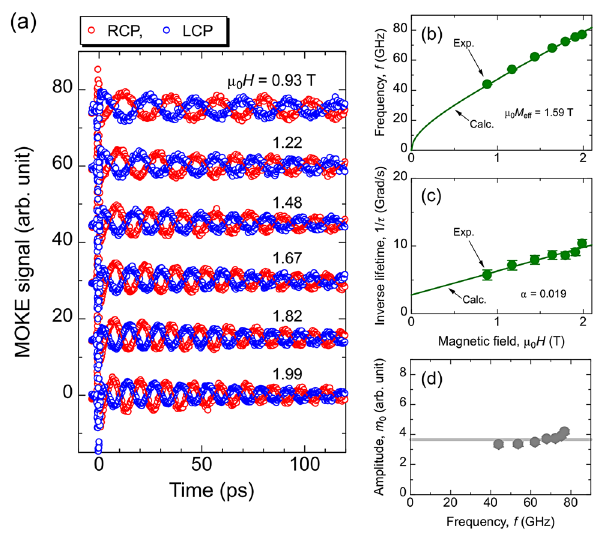
Figure 2: (a) Circularly polarized laser pulse induced magnetization precession in 2-nm-thick FeCo/3-nm-thick Pt bilayer with different magnetic fields μ 0 H . (b) Precession frequency and (c) inverse lifetime obtained by fi tting plotted as a function of magnetic fi eld. Solid curves are the results calculated using theoretical formula. (d) Precessionamplitudeplotted as a function of precessionfrequency. Horizontal line is a guide to